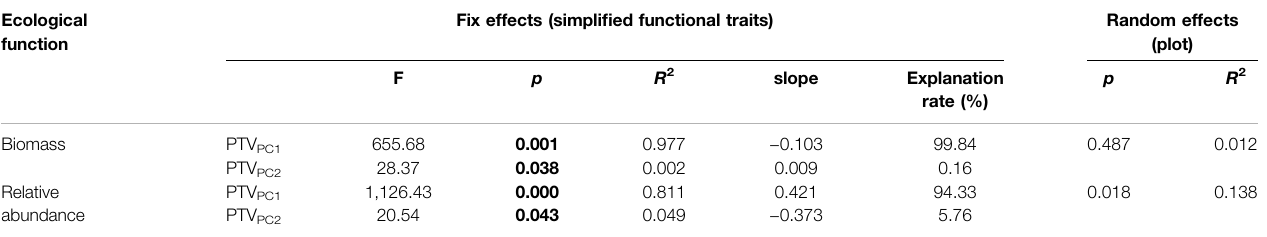
TABLE 3 | Linear mixed model results of the effects of functional traits on total biomass and relative abundance of P. fruticosa. The p -values less than 0.05 are in bold. PTV PC1 , the fi rst axis of the PCA of functional traits; PTV PC2 , the second axis of the PCA of functional traits. Ecological function